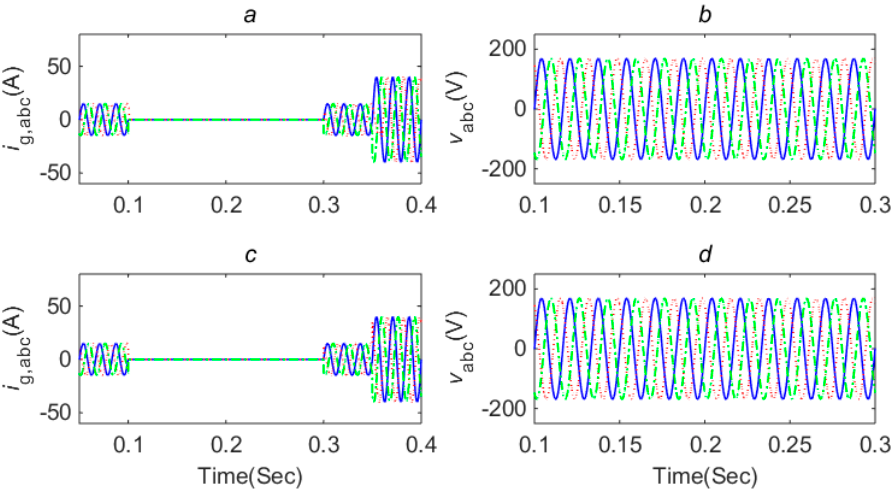
Figure 3. Exchange current and load voltage ( a , b are under robust higher-order sliding mode (RHOSM) and c , d are under higher-order sliding mode (AHOSM)).